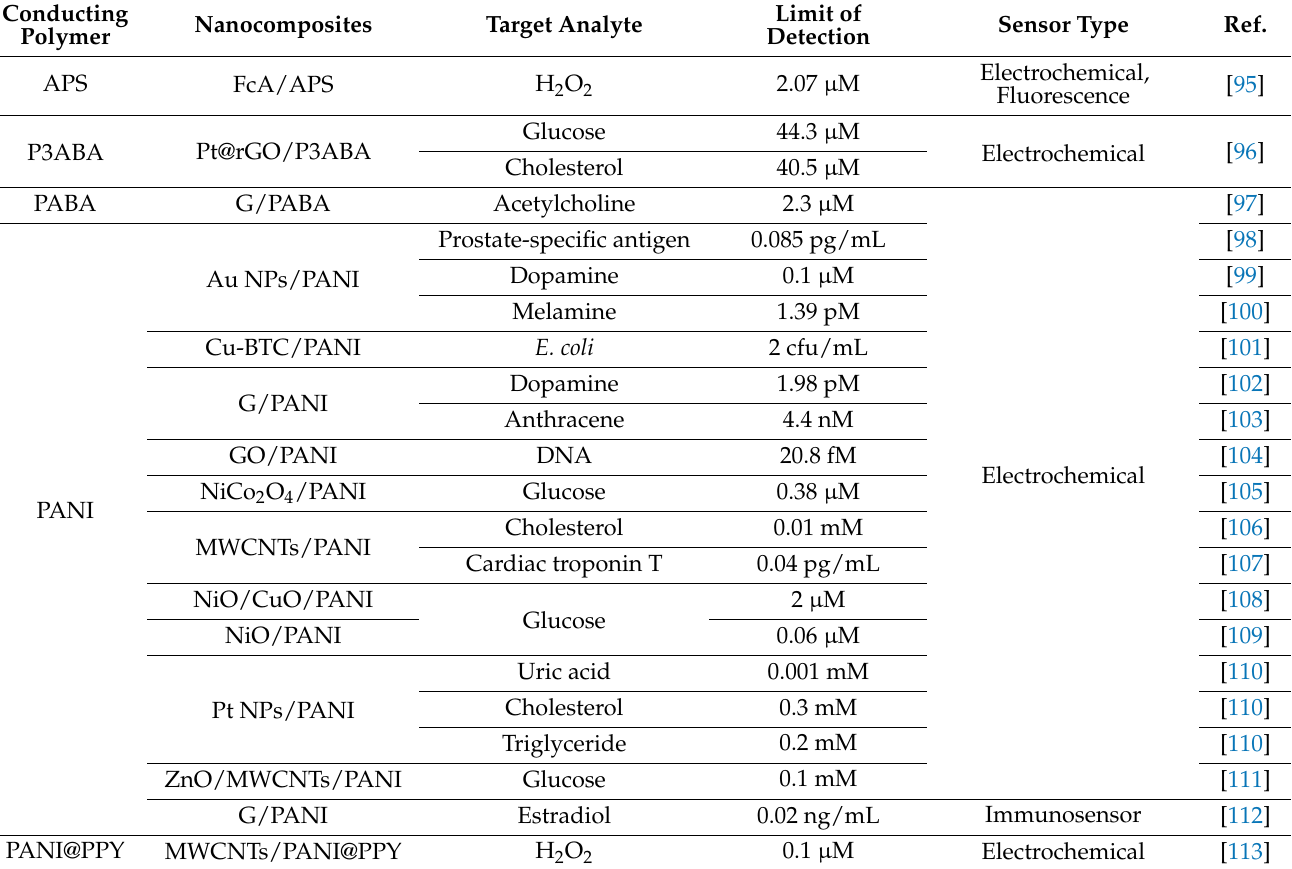
Table 3. Various nanoparticles/conducting polymer-based nanocomposites and their characterization techniques, target analyte, and detection